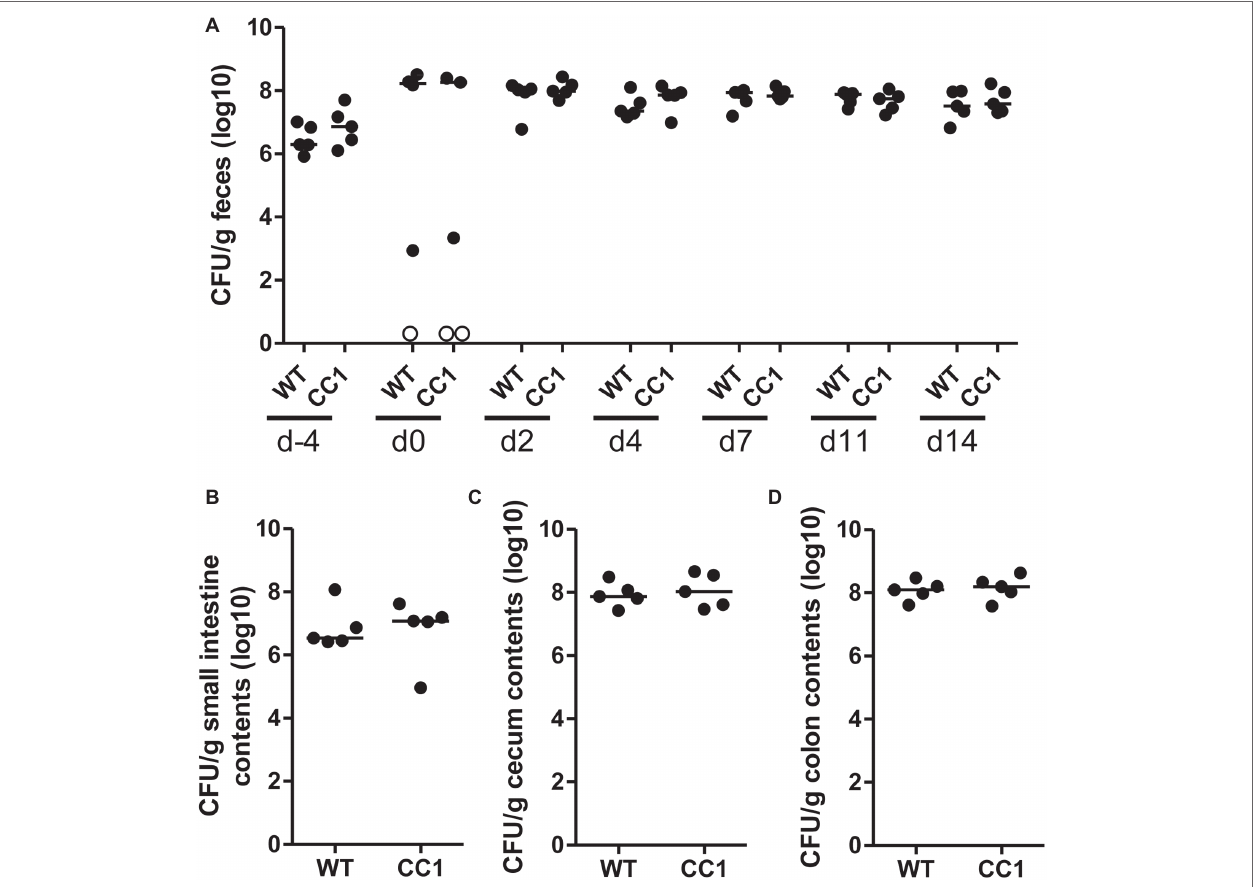
FIGURE 3 | The expression of human CEACAM1 does not influence the intestinal colonization by C. albicans . Human CEACAM1-transgenic mice (CC1, N = 5) and their wild-type littermates (WT, N = 5), co-housed in two cages, were treated with antibiotics from day −4, inoculated with 5 × 10 7 CFU C. albicans orally at day 0 and injected with cyclophosphamide at day 11 (see also Table 1 ). Feces were collected from individual mice at the days indicated and analyzed for CFU content by plating dilutions on YPD agar (A) . Note that similar CFUs were detected on YPD agar containing 80 μg/ml chloramphenicol ( Supplementary Figure S1B ). Open circles represent samples without any CFUs detected by plating on either YPD plate type. On day 14, mice were sacrificed and contents from small intestine (B) , cecum (C) , and colon (D) were collected by rinsing intestines with PBS and analyzed for their CFU content. Graphs show CFU/g feces (log10) with median. Statistical analysis was performed with logarithmized data by one-way ANOVA and Bonferroni post-test (A) or by unpaired, two-sided Student’s t tests (B–D) ; no significant differences were detected between the two genotypes at any time/in all matching contents ( B : p = 0.879, C : p = 0.671, D : p = 0.729). All data are from one single